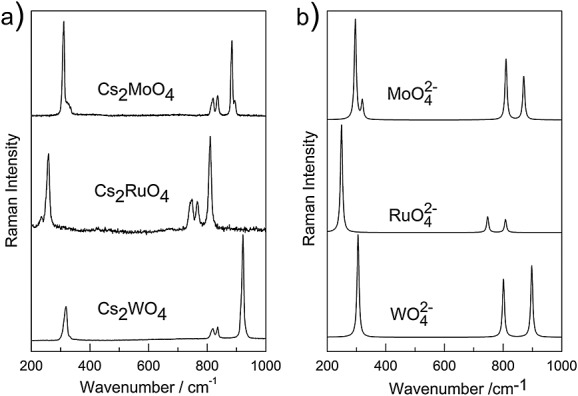
(a) Experimental Raman spectra of Cs2WO4, Cs2RuO4, and Cs2MoO4 at room temperature. Power at the surface is 2 mW. (b) Computed Raman spectra of the WO42−, RuO42−, and MoO42−moieties.